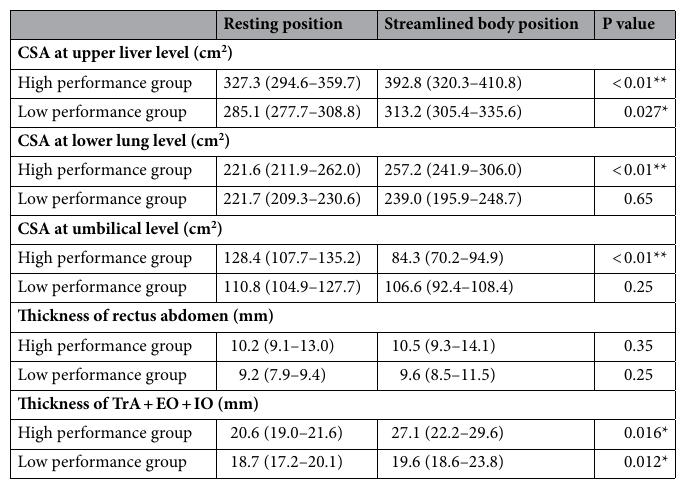
Table 2. Comparisons of CSA and thickness of abdominal wall muscle within groups. All data are presented as medians with interquartile ranges. CSA cross-sectional area, TrA transversus abdominis muscle, EO external oblique muscle, IO internal oblique muscle. *p < 0.05, **p < 0.01.